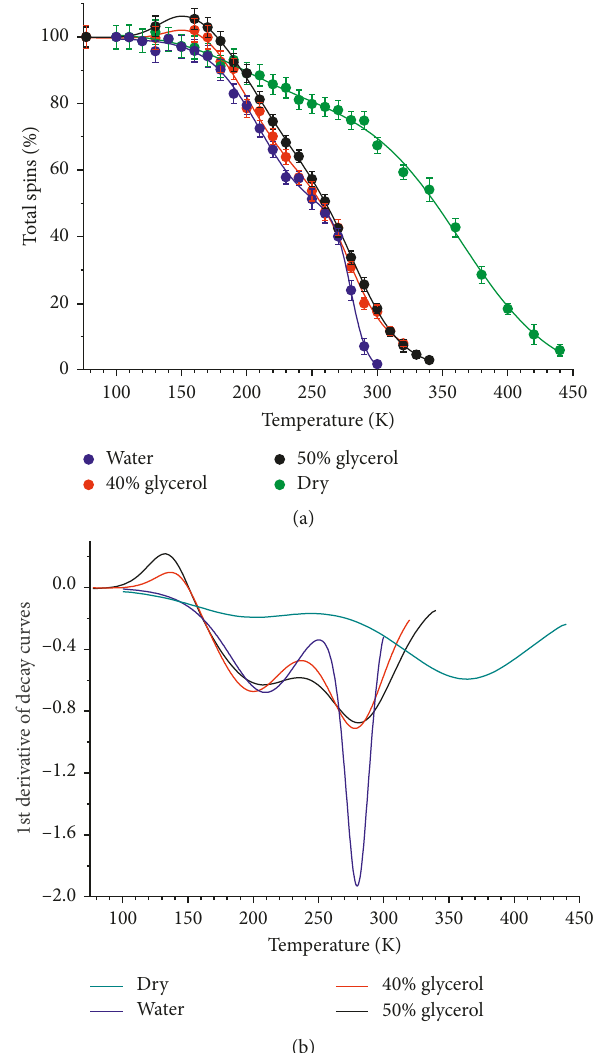
Figure 3: (a) The thermal decay curves of the free radicals induced by UV irradiation of silk fibroin in various hydrated and dry states and their respective first derivative curves. (b) Derivative curves were obtained using smooth lines connecting data points.